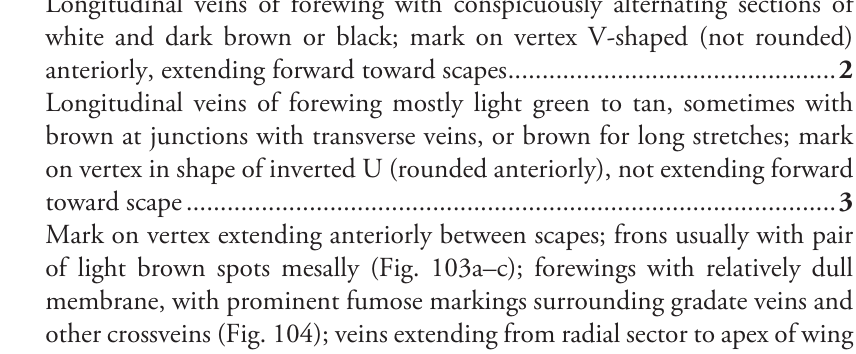
Longitudinal veins of forewing with conspicuously alternating sections of white and dark brown or black; mark on vertex V-shaped (not rounded) Longitudinal veins of forewing mostly light green to tan, sometimes with brown at junctions with transverse veins, or brown for long stretches; mark on vertex in shape of inverted U (rounded anteriorly), not extending forward Mark on vertex extending anteriorly between scapes; frons usually with pair of light brown spots mesally (Fig. 103a–c); forewings with relatively dull membrane, with prominent fumose markings surrounding gradate veins and other crossveins (Fig. 104); veins extending from radial sector to apex of